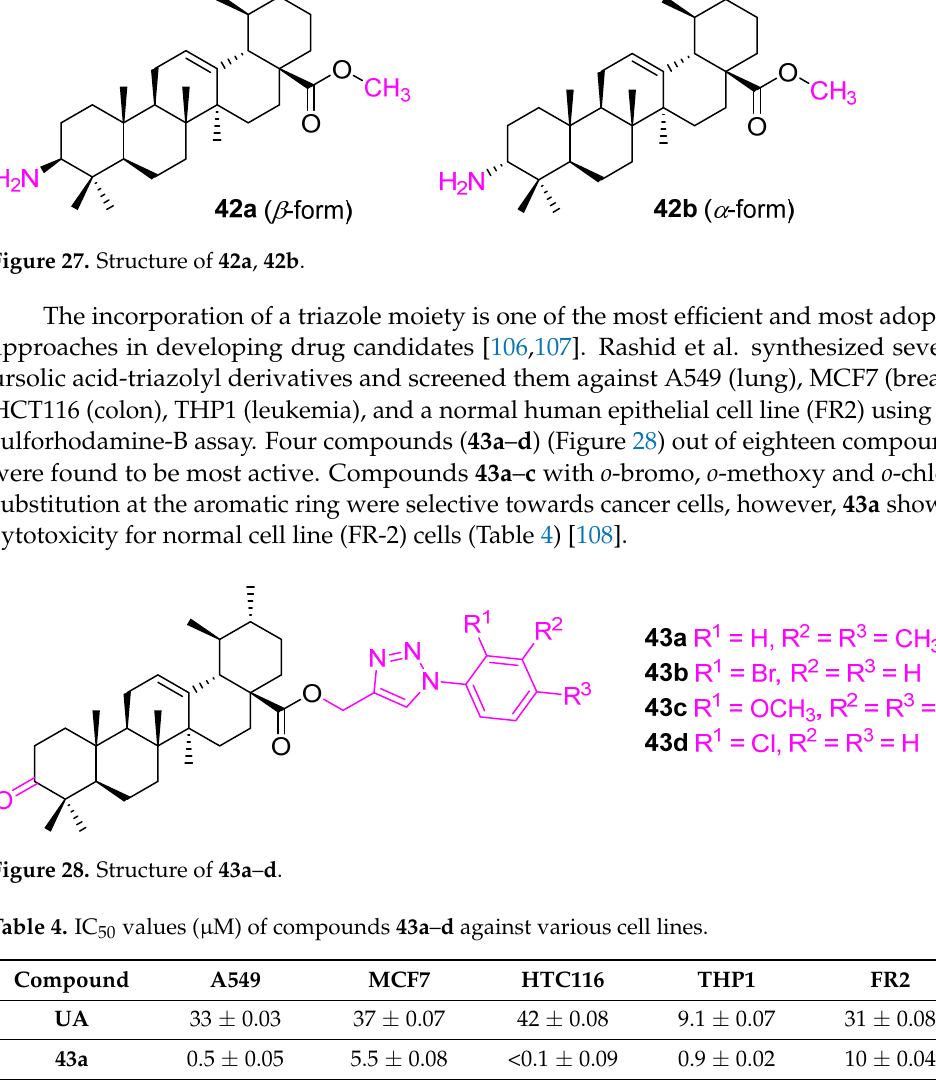
Figure 26. Structure of 40 , 41 .